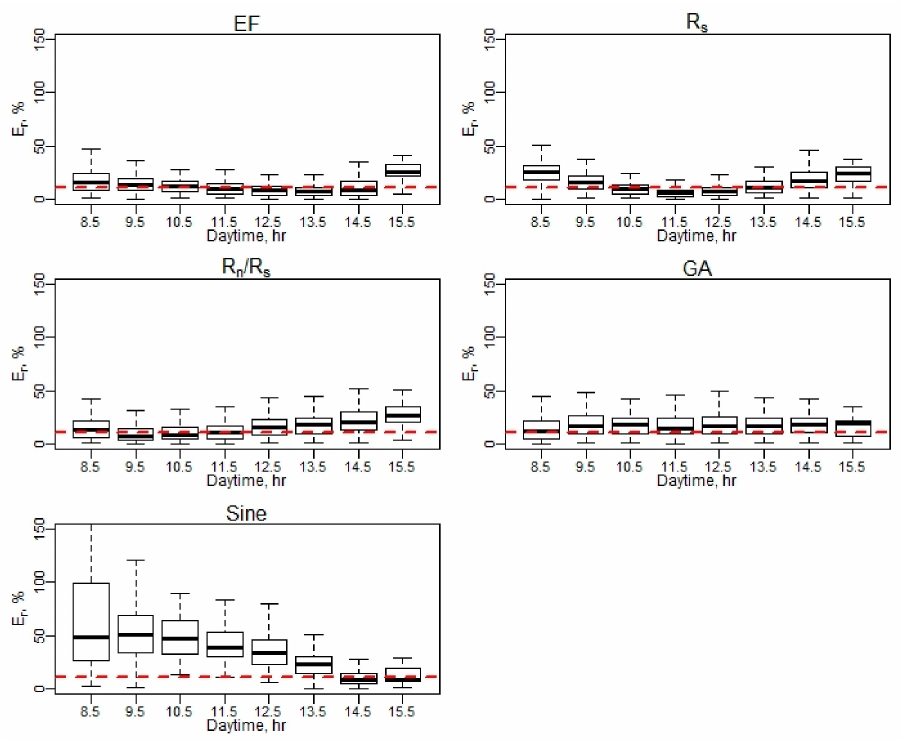
Figure A17. E r of daily EC ET (September–October). Note: Red dash line represents a 10% relative error ( E r ).